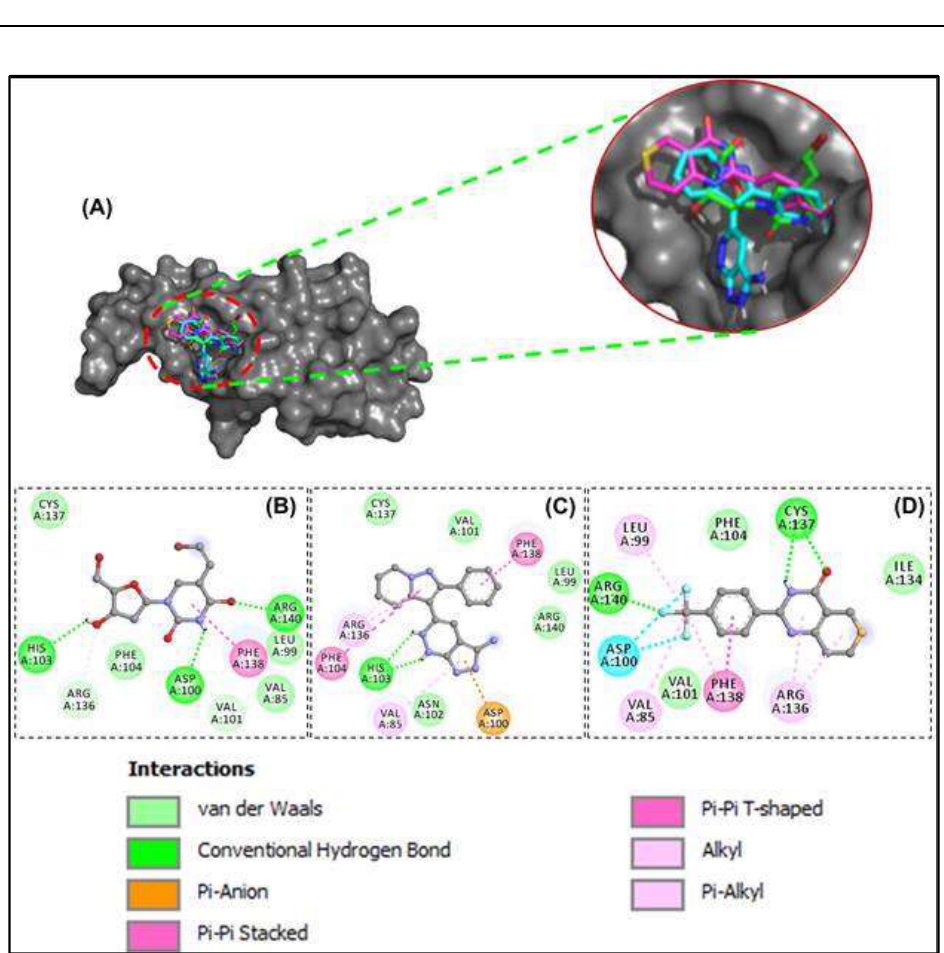
Figure 3. Molecular docking of anti-cancer compounds against HSP27. ( A ) The 3D binding configuration of BVDU (green), FR180204 (cyan) and XAV-939 (pink). All three ligands occupied similar spot of our protein target. The molecular interaction fingerprints in 2D showed that atoms of our ligands ( B ) BVDU ( C ) FR180204 ( D ) XAV-939 interacted with amino acid residues important for binding between two HSP27 monomers.